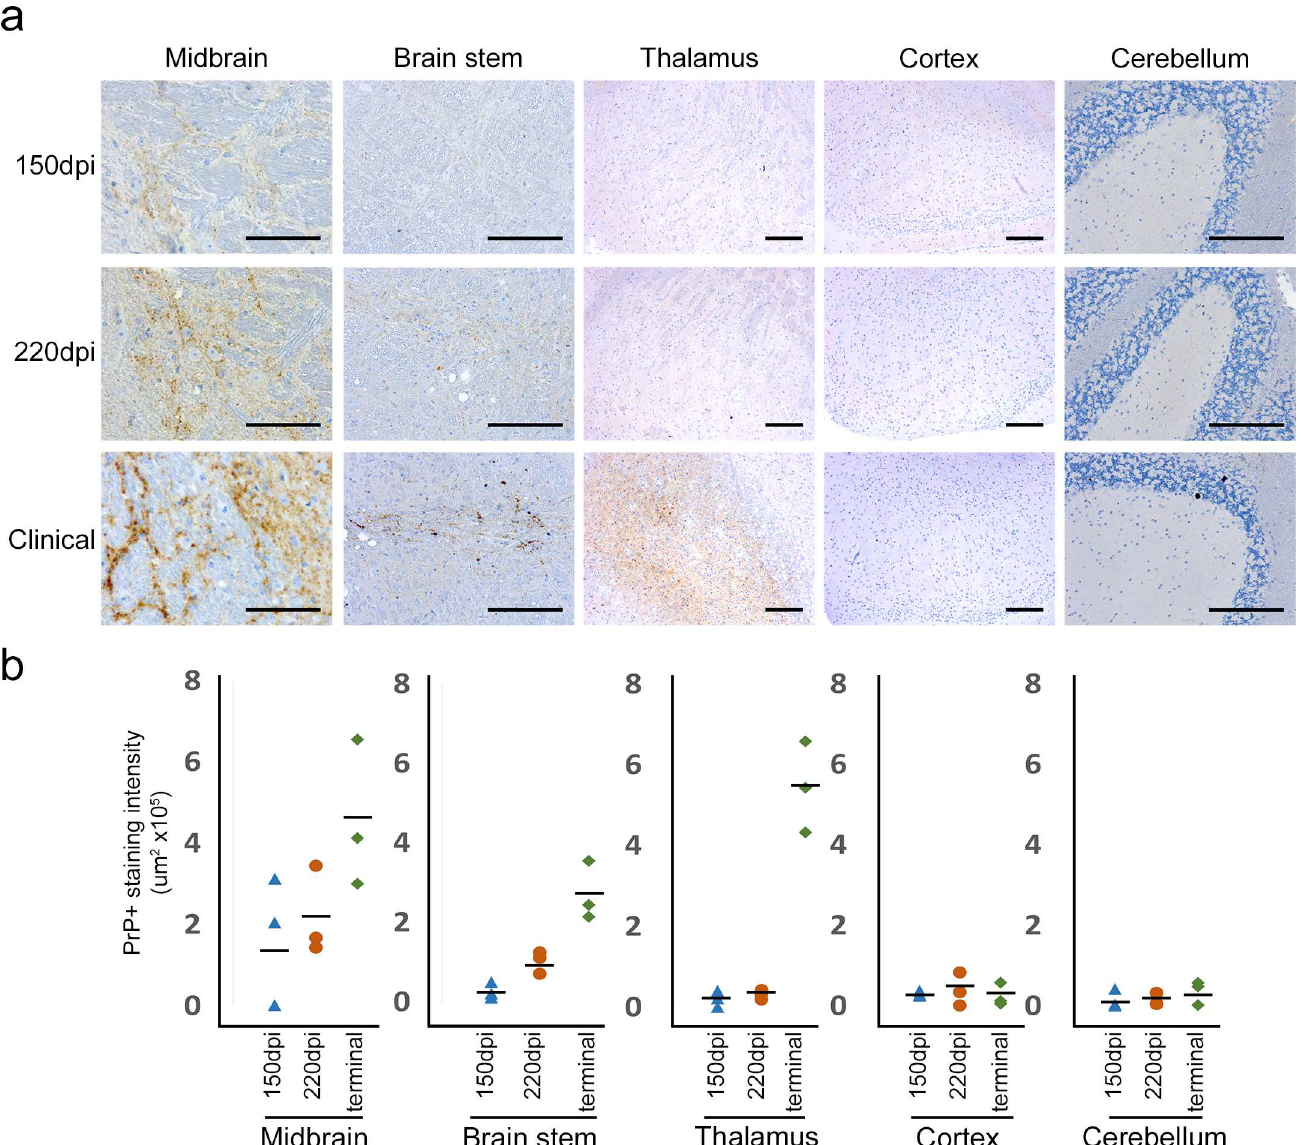
Fig 1. Detection of misfolded PrP using IHC at different time-points in different brain regions. (a) At 150 dpi, small quantitiesof fine-punctate misfoldedPrP depositscan be detected in the midbrain.This positive stainingcould be observedin five of twelve GSS/101LL mice tested, but no staining was observedin any NBH/101LL animal in any brain region( n = 12). At 220 dpi, fine-punctate misfoldedPrP depositswere detectablein both the midbrainand brain stem, which was observedin four of six GSS/101LL mice tested, but no stainingwas observedin any NBH/101LL animal in any brain region( n = 6). At clinical onset of disease(291.1 ± 5.3 dpi), misfoldedPrP stainingcould be observedin midbrain,brain stem, and the thalamus but not in cortex or cerebellum in GSS/101LL mice. This staining pattern was observedin all mice tested at this stage ( n = 9), whereasno stainingwas observed in any NBH/101LLanimalin any brain regiontested ( n = 4). Scale bars: midbrain = 100 μ m, brain stem, thalamus, cortex, and cerebellum= 200 μ m. (b) Quantification of PrP+ stainingintensity. The levels of PrP+ stainingare originallyhigh in the midbrain,but at later time-points in other brain regions, such as brain stem and thalamus, the levels of PrP+ stainingincreaseto comparable levels to that of the midbrain.In cortex and cerebellum,no changein PrP+ stainingwas observed. Quantitationwas performed using colour deconvolution plug-into Image-J software.